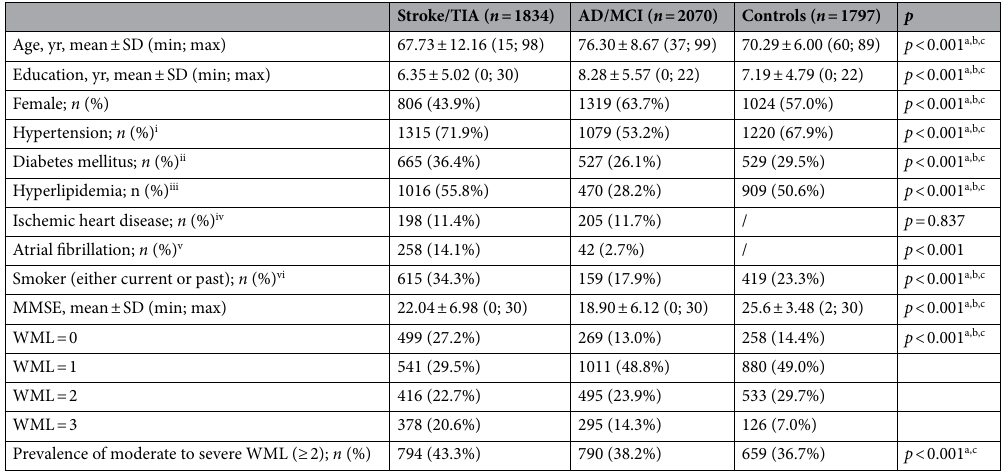
Table 1. Clinical demographics of different disease groups and controls in the AWARE study. This table illustrated the clinical demographics of the disease groups and controls in the AWARE study. For post-hoc group comparisons, a AD/MCI versus stroke/TIA. b AD/MCI versus controls. c Stroke/TIA versus controls. Total number of inclusion cases were i n = 5653; ii n = 5643; iii n = 5286; iv n = 3497; v n = 3366; vi n = 4478. MCI Mild cognitive impairment, AD Alzheimer’s disease, TIA Transient ischaemic attack, MMSE Mini-mental state